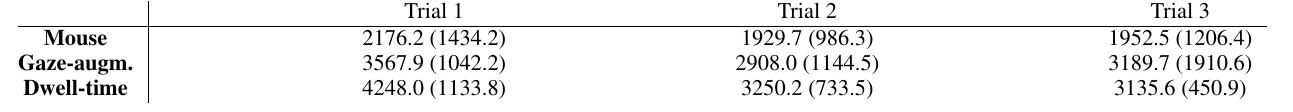
Inter-move latency in milliseconds (with standard deviation) as a function of trial and interaction modality.